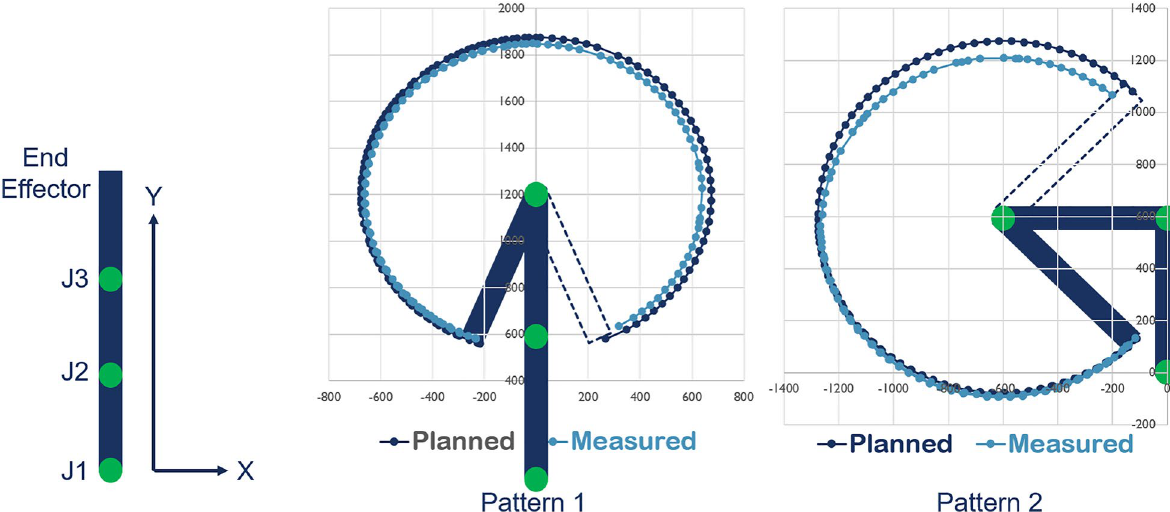
Fig. 4 End effector trajectory comparison results of Pattern 1 and 2. A The coordinate system in the image. B The result of Pattern 1. C The result of Pattern 2